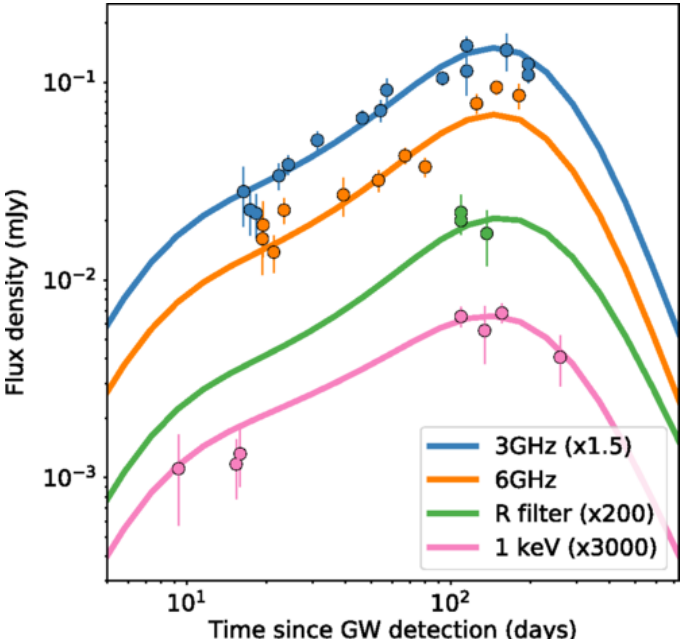
Figure 37. Best fit light curves to the ROX AG of SHB170817A up to April 2018, obtained from a structured jet model [192]. Reported in version 4 of [192] posted in the arXiv on 11 May 2018.